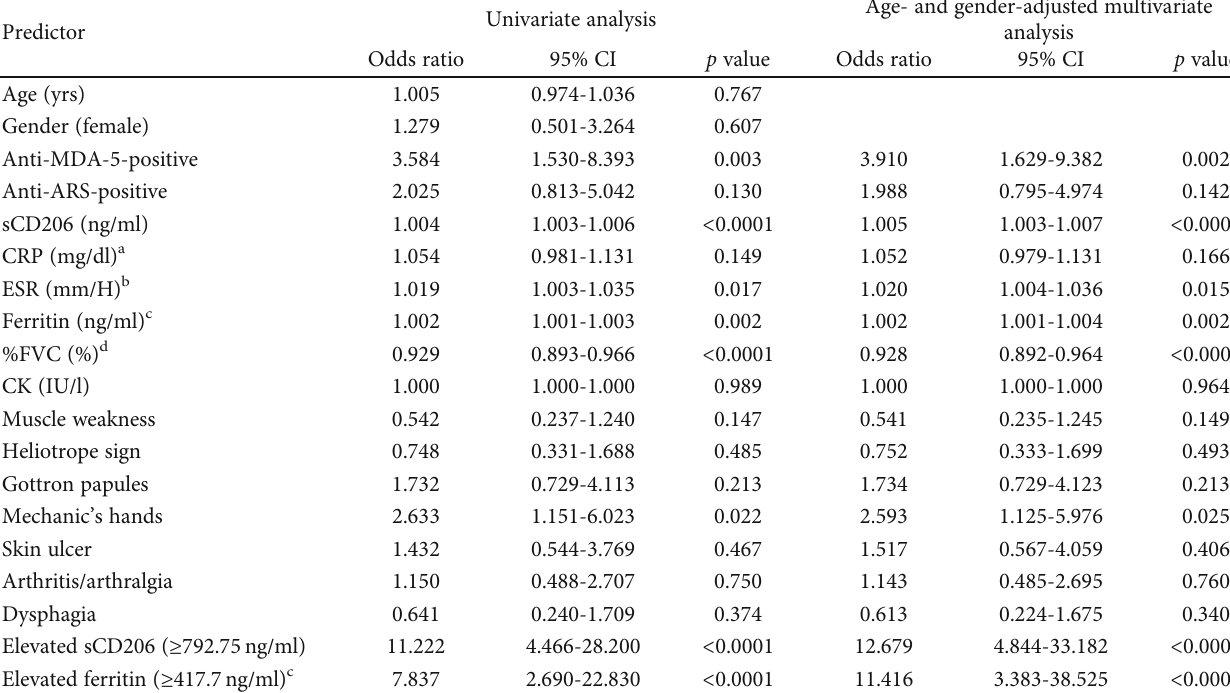
Table 2: Predictive factors for RP-ILD in DM patients using univariate and age- and gender-adjusted multivariate logistic regression analyses.